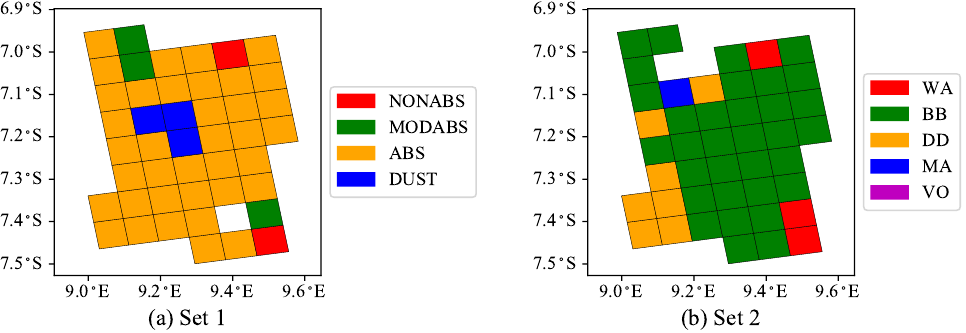
Figure 8. True-color VIIRS images recorded on ( a ) 4 and ( b ) 5 July 2019.